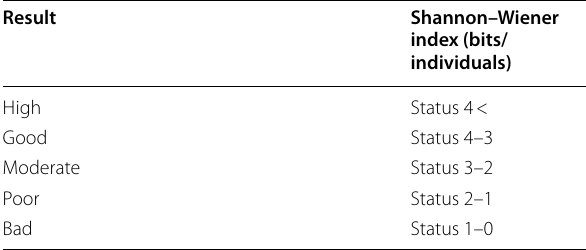
Table 2 Shannon–Wiener index range for the health of an ecosystem